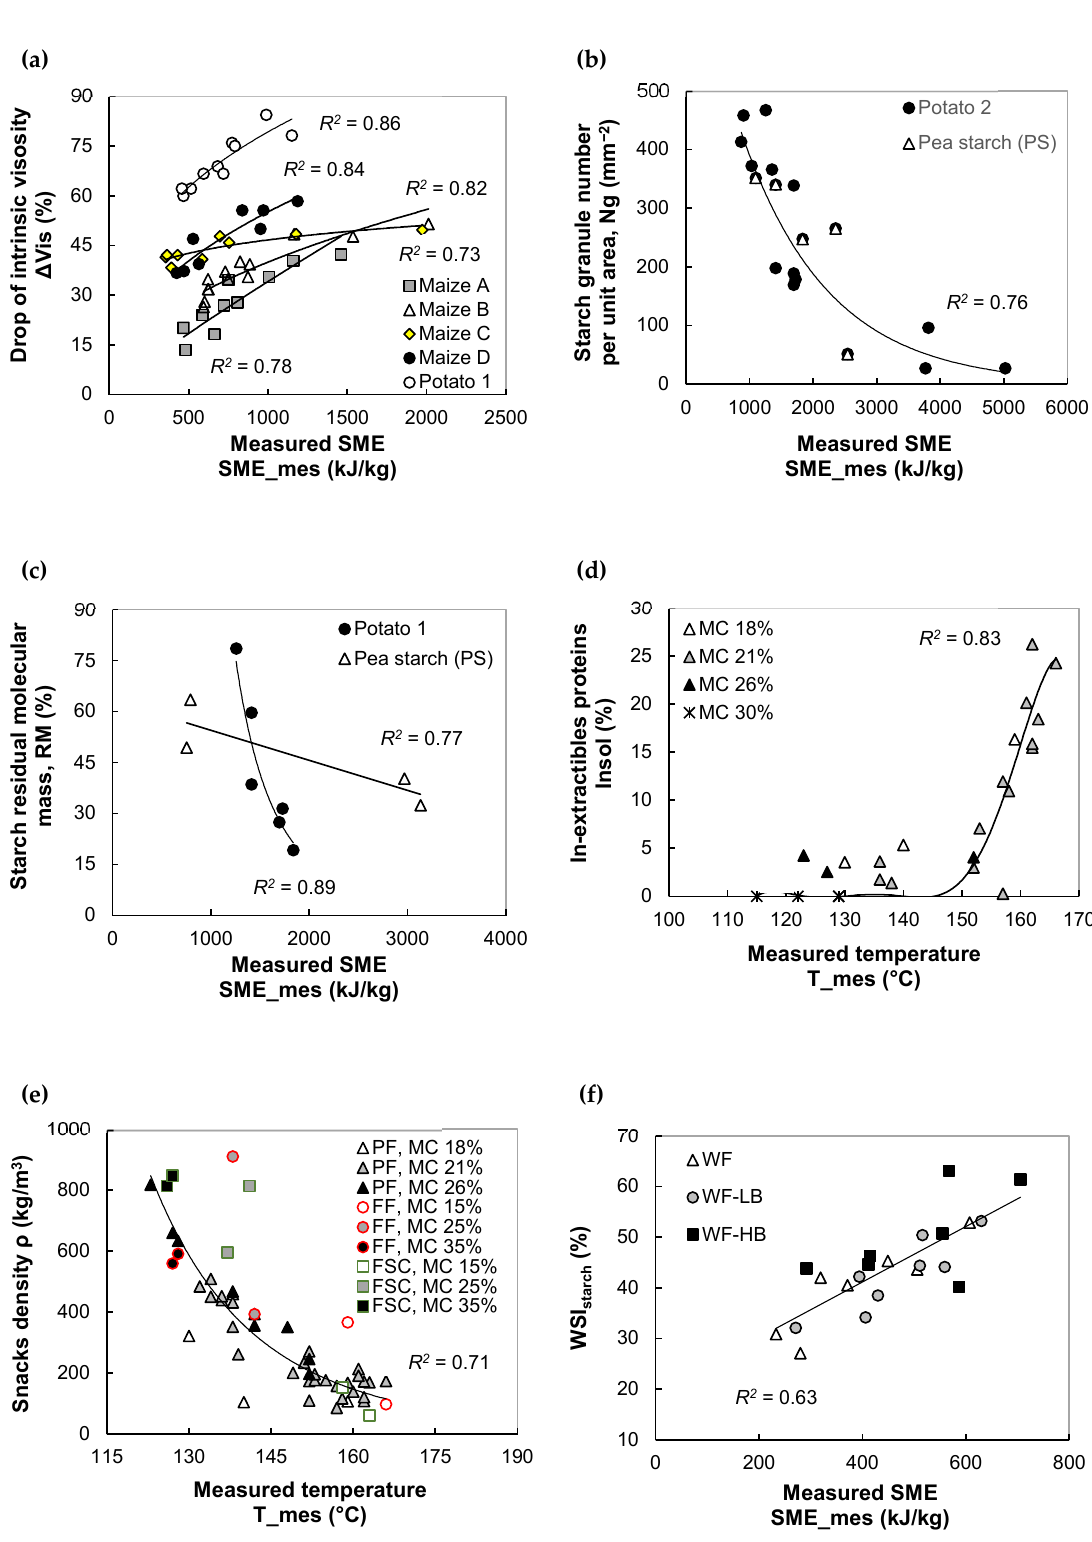
Figure A4. Impact of measured extrusion variables on product features. ( a ) Variation of the drop of intrinsic viscosity of expanded maize and potato starches with measured SME, ( b ) variation of remnant granule number per unit area of non-expanded starches with measured SME, ( c ) variation of residual molecular mass of non-expanded starches with measured SME, ( d ) variation of insoluble proteins and density ( e ) of legumes-based snack with measured melt temperature, ( f ) change of wheat snacks’ water solubility index of starch (WSI starch ) with measured